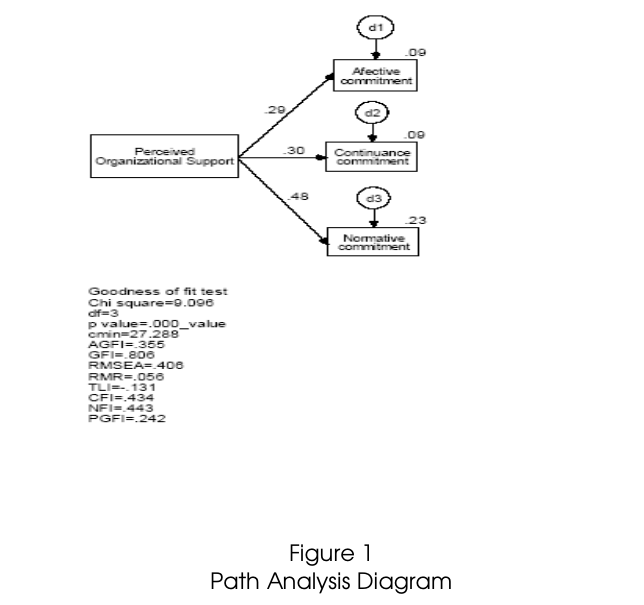
Path Analysis Diagram